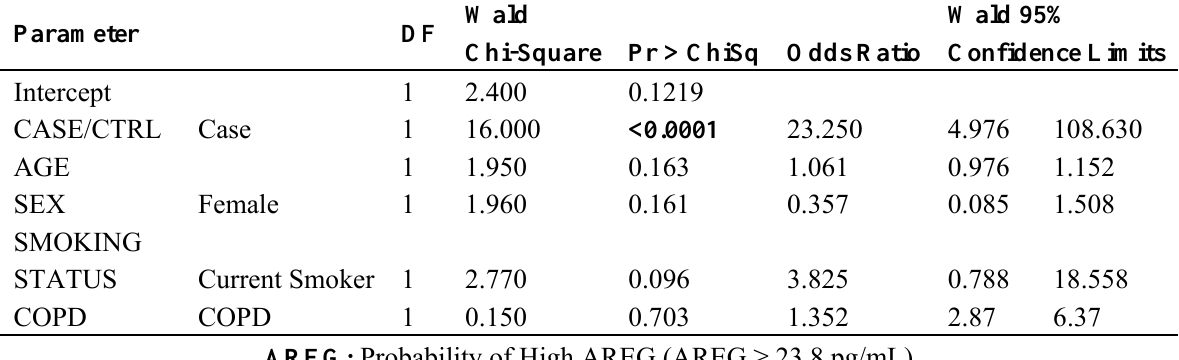
Table 3. Association of patient characteristics with HGF, TGF  and AREG serum level. HGF: Probability of High HGF (HGF ≥ 1510